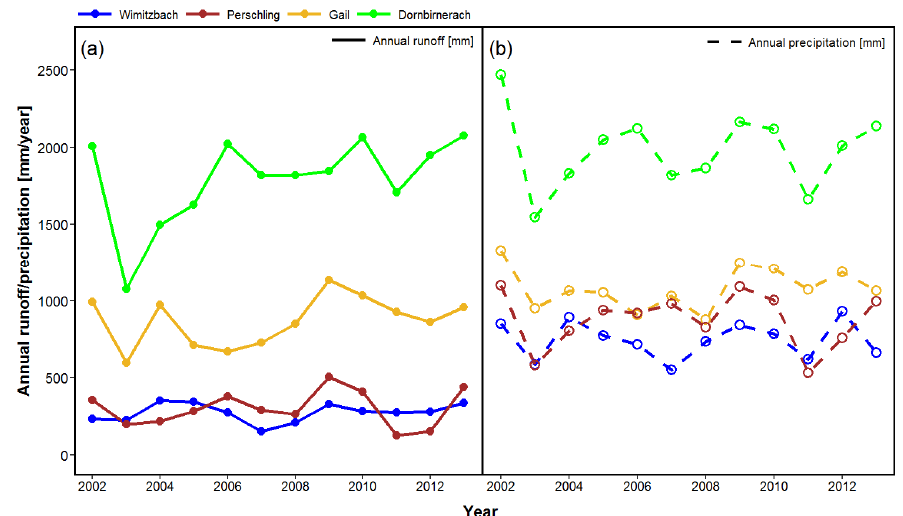
Figure 2. Inter-annual dynamics of mean annual precipitation ( a ) and runoff ( b ) in four Austrian catchments in the period 2002–2013.